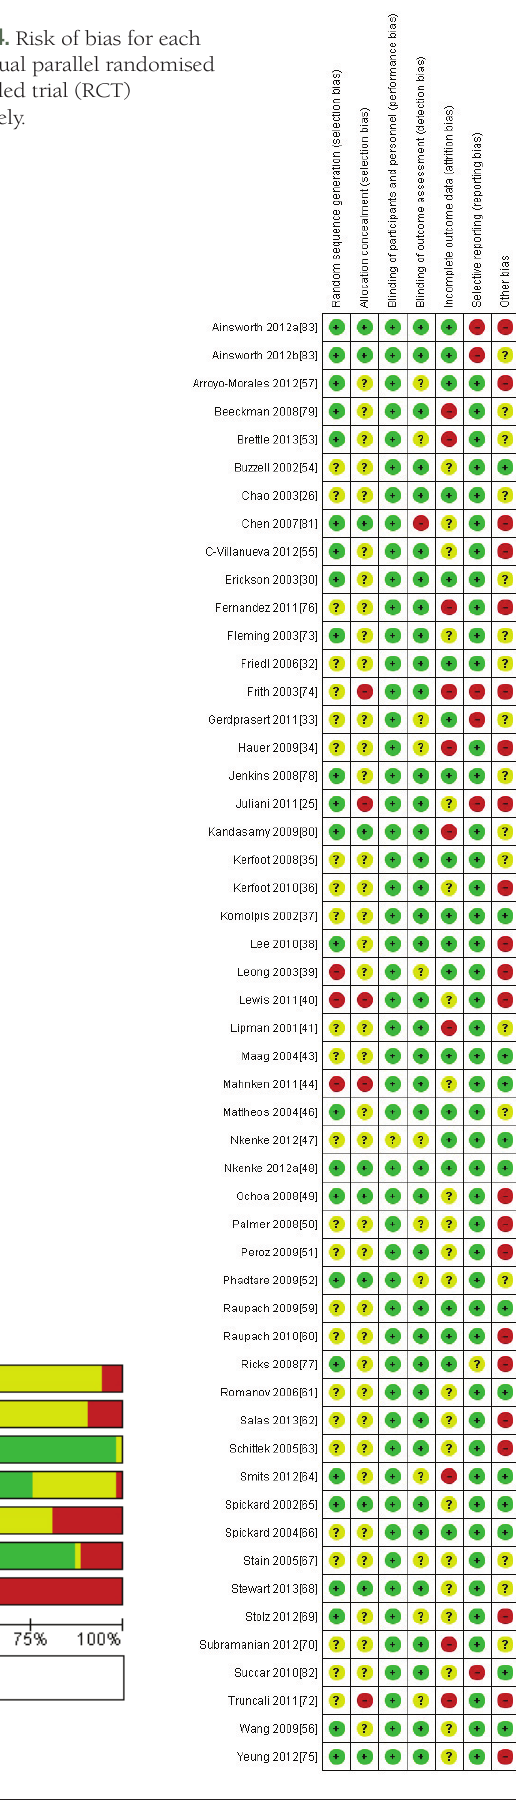
Figure 4. Risk of bias for each individual parallel randomised controlled trial (RCT)